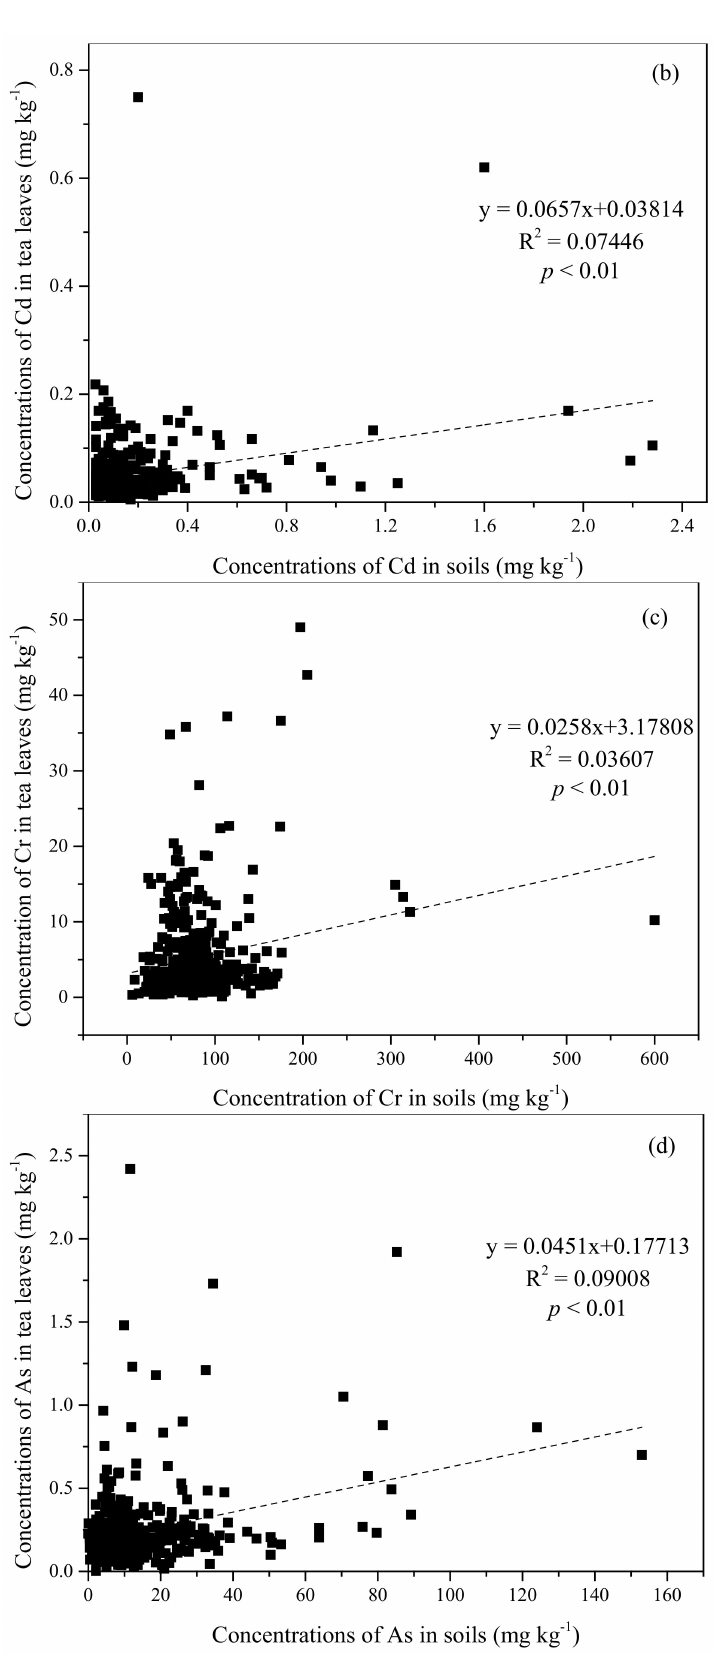
Figure 3. The relationship between the concentrations of heavy metals (i.e., ( a ) Pb, ( b ) Cd, ( c ) Cr, and ( d ) As) in soil and corresponding tea leaves. Sample size =